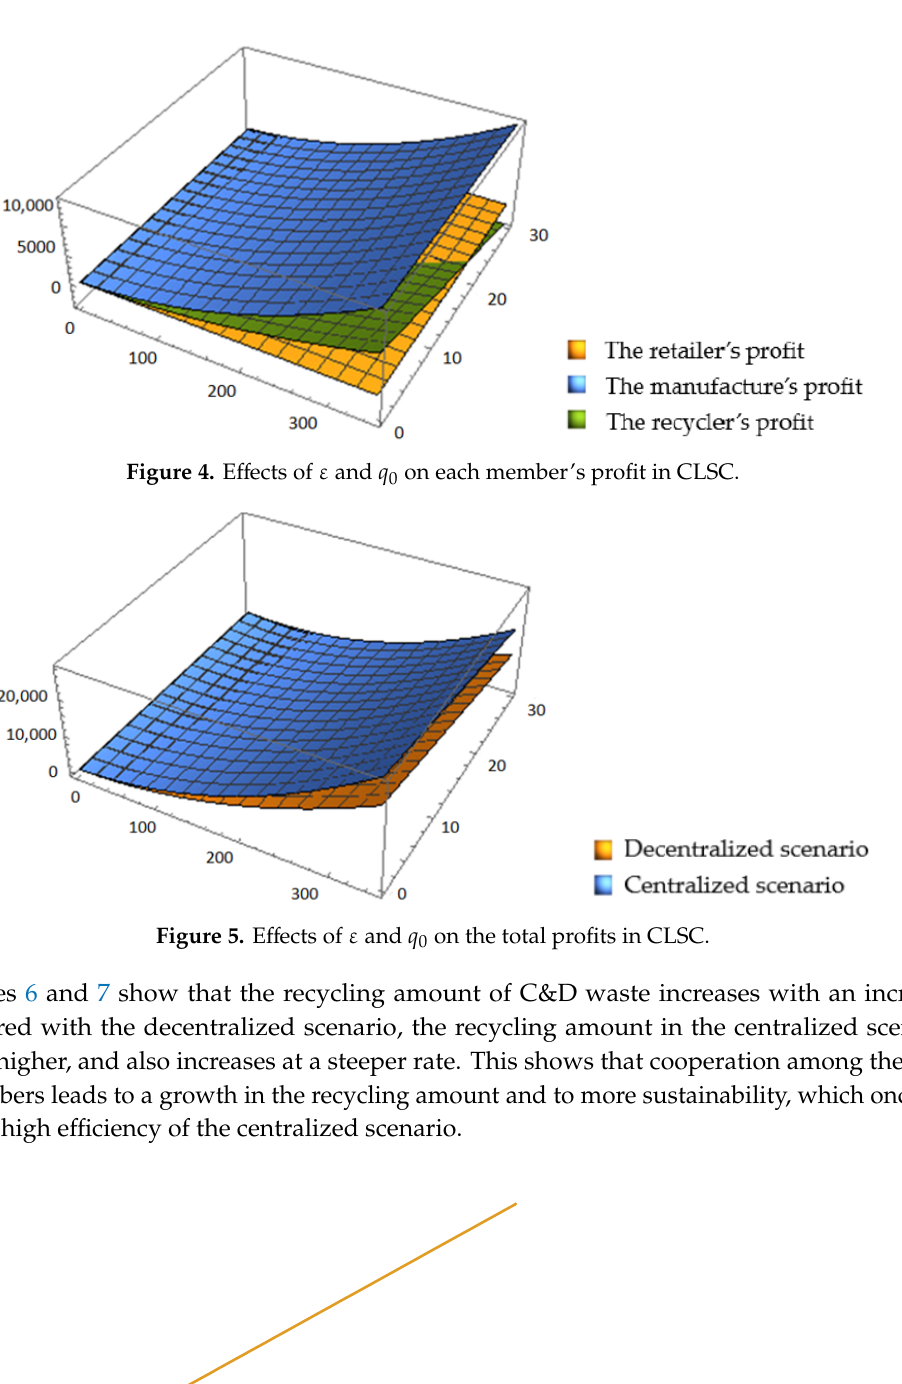
Figure 3. Effect of  on profits in CLSC with government regulation.